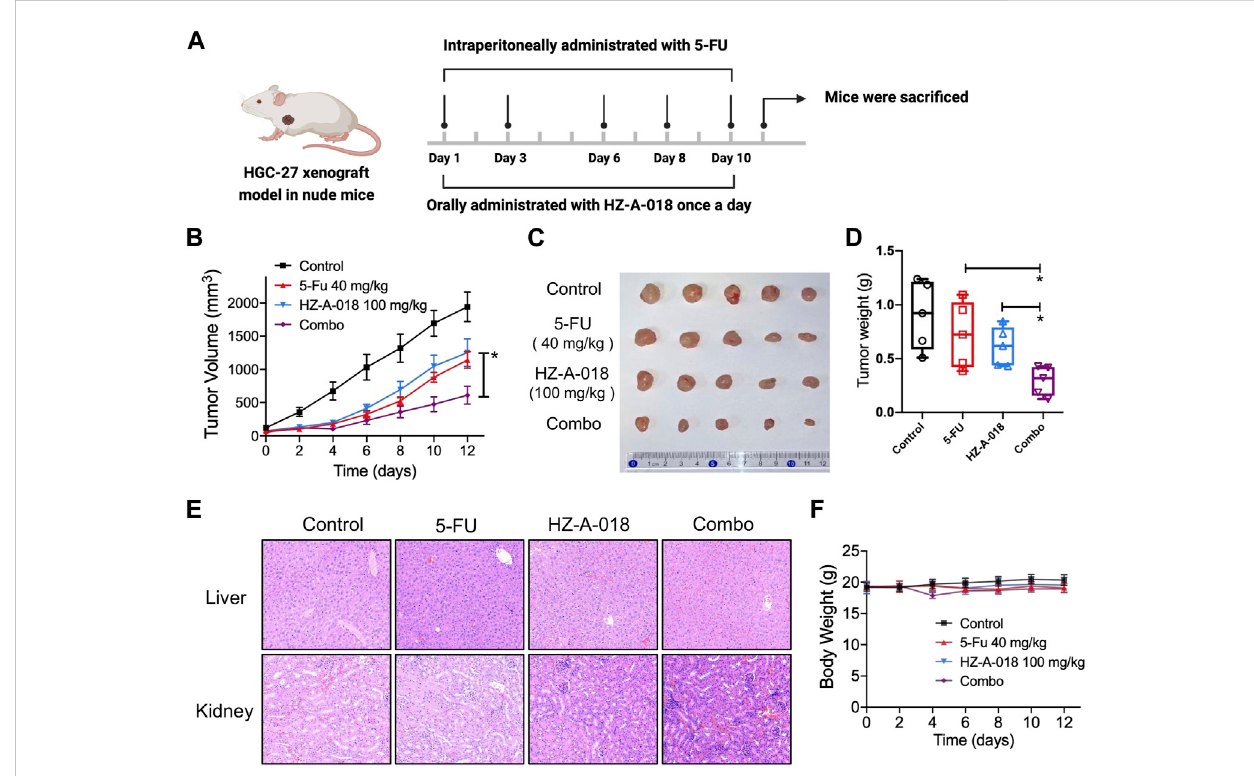
FIGURE 3 Thesynergisticantitumoreffectof5-FUandHZ-A-018inHGC-27xenograftnudemicemodels. (A) Experimentalscheduleof invivo administration withindicateddrugs. (B) Tumorvolumewasmeasuredandrecordedeveryotherday.Datawerepresentedasmean±SEM. (C) Dissectedtumortissuesin thecontrolandtreatedgroups. (D) Tumorweightofcontrolandtreatedgroups. (E) H&Estainofliverandkidneytissuesinthecontrolandtreatedgroups. (F) Changes of mice body weight during experimental period. * p <